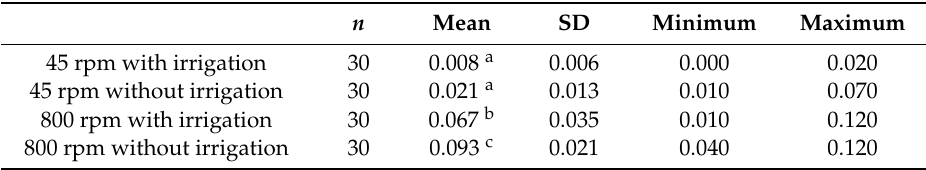
Table 1. Descriptive statistics of the radiographic results (mm).